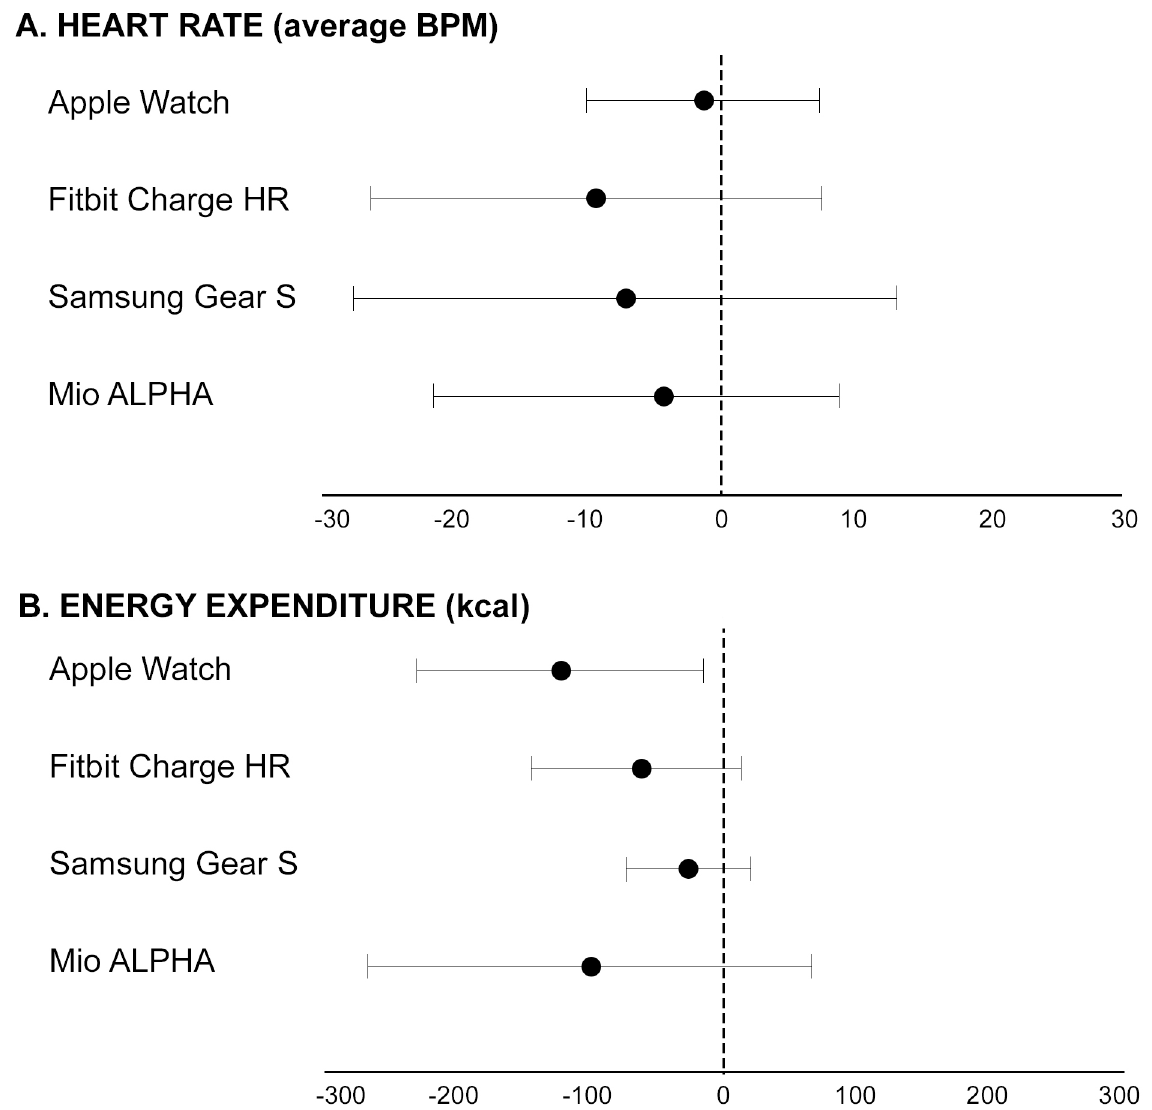
Fig 2. Bland-Altman analyses comparing devices with reference method for (A) heart rate and (B) energy expenditure. Mean difference is indicated by the solid dot, with the lines indicating the 95% limits of agreement. Notes : HR = heart rate, kcal = kilocalories, bpm = beat per minute. Where mean difference or limits of agreement were systematically biased, point estimates were calculated using the mean value for the average of the two measures (device and reference).